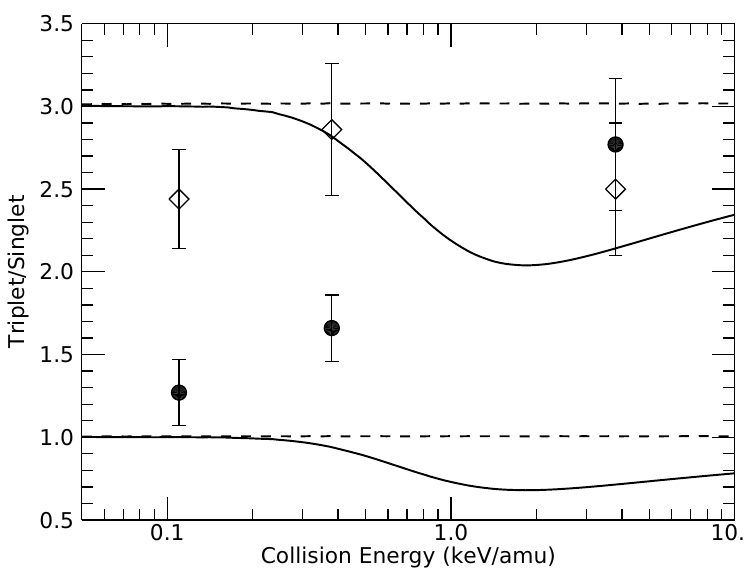
Figure 3. Experimental and theoretical [22] velocity dependence of triplet-to-singlet ratios for collisions between C 5 + and H 2 O. Shown are the TS 3 ratio for capture into 1 s 3 d and 1 s 4 f (filled circles and solid line) and the TS 4 ratio for capture into 1 s 4 s and 1 s 4 d (open diamonds and dashed line). For comparison, a second pair of the theoretical curves is depicted which are obtained by multiplying the original theoretical results by a factor of three to represent a statistical spin state